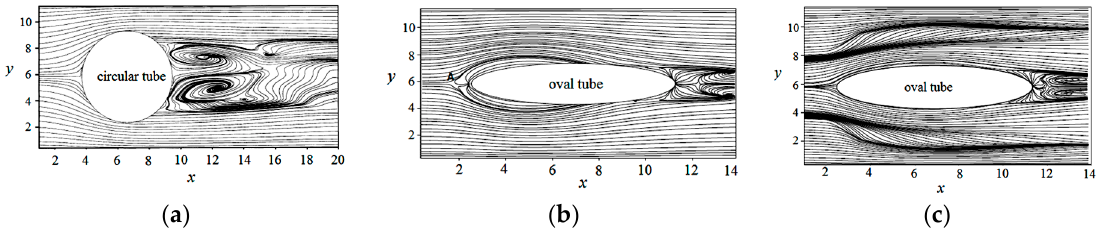
Figure 16. Streamline plot of the instantaneous field at the mid-plane [74]. ( a ) For circle tubes without VGs. ( b ) For flat tubes without VGs. ( c ) For flat tubes with VGs. VGs. ( b ) For flat tubes without VGs. ( c ) For flat tubes with